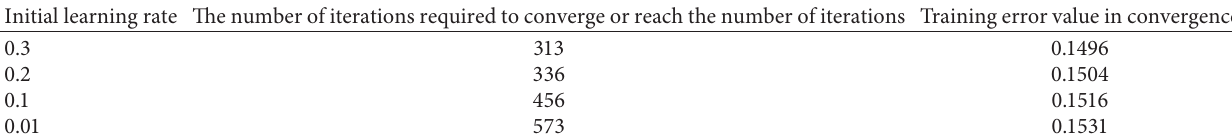
Figure 10. 2% of the labeled samples should include the first 1% of the labeled samples. In the same way, 3% of the labeled samples should include the first 2% of the labeled samples and so on.